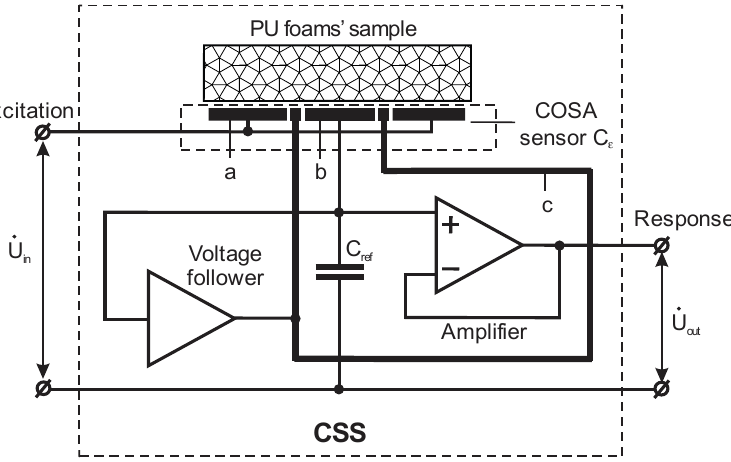
Figure 1. A simplified functional diagram of the capacitive one-side access sensor system; “a”—driven electrode, “b”—sensing electrode; and “c”—guard electrode.